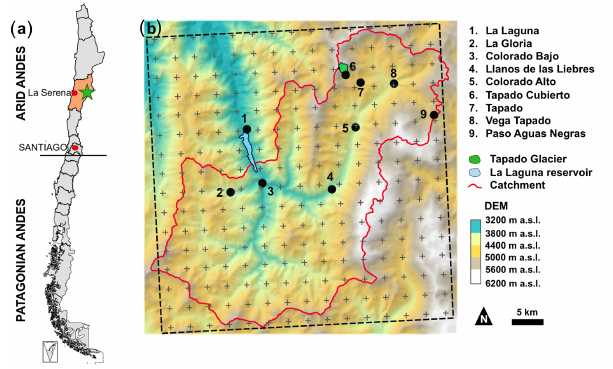
Figure 1. (a) Map of Chile with the Coquimbo region colored or- ange and the catchment location identified with a star. (b) DEM (SRTM, 100m) of La Laguna catchment. The red line corresponds to the catchment delineation, and the black dashed line to the WRF domain containing the virtual WRF stations (grey crosses). The blue area is La Laguna reservoir and the green area is the Tapado Glacier. AWSs are the nine black